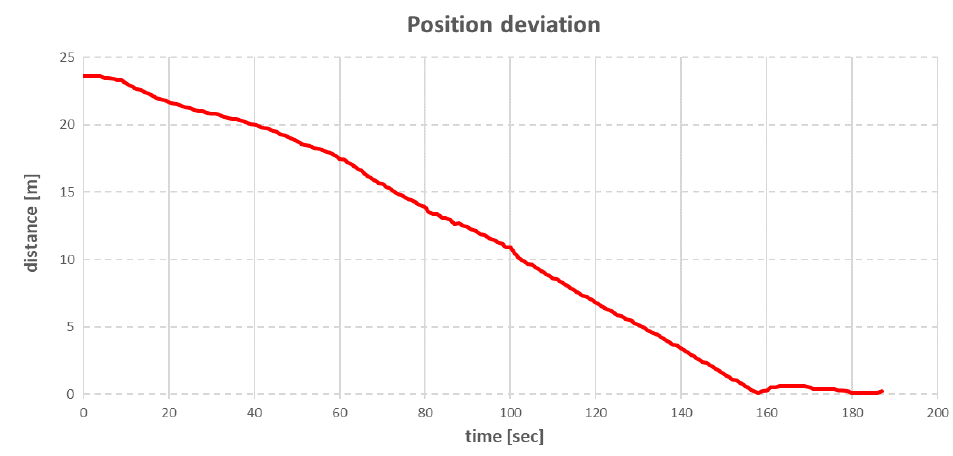
Figure 14. The ship ’ s position deviation after changing target position.